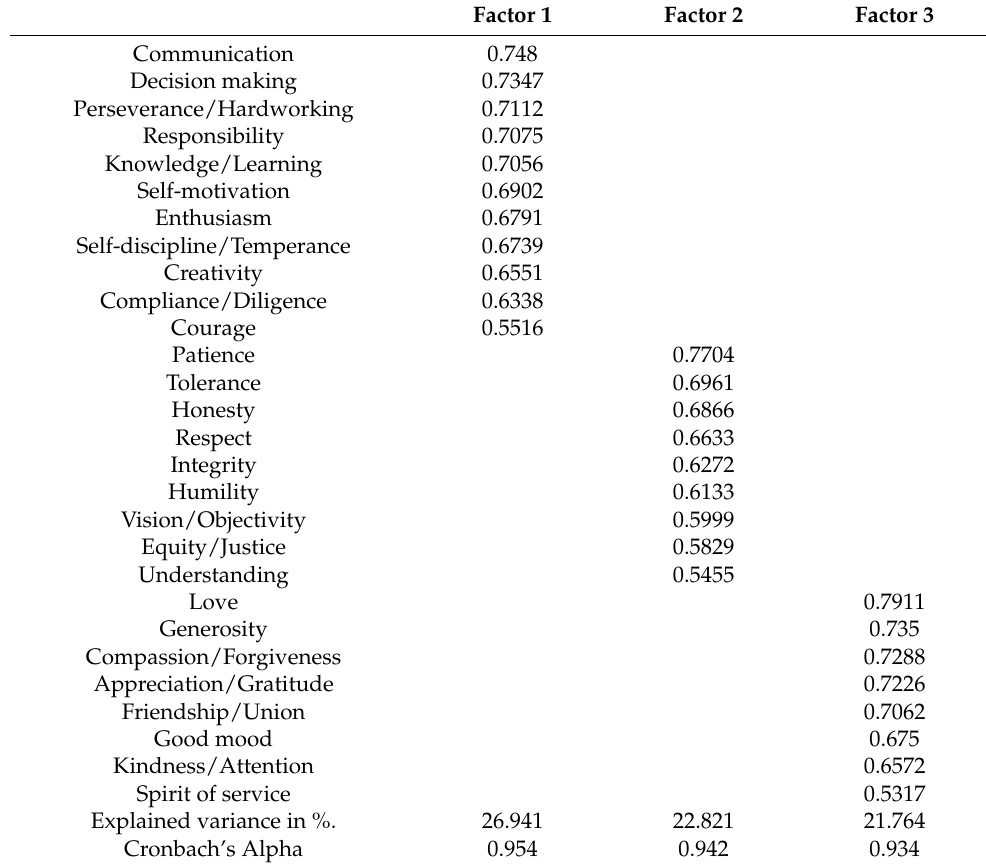
Table 13. The composition of factors of ethical values presents ineffective